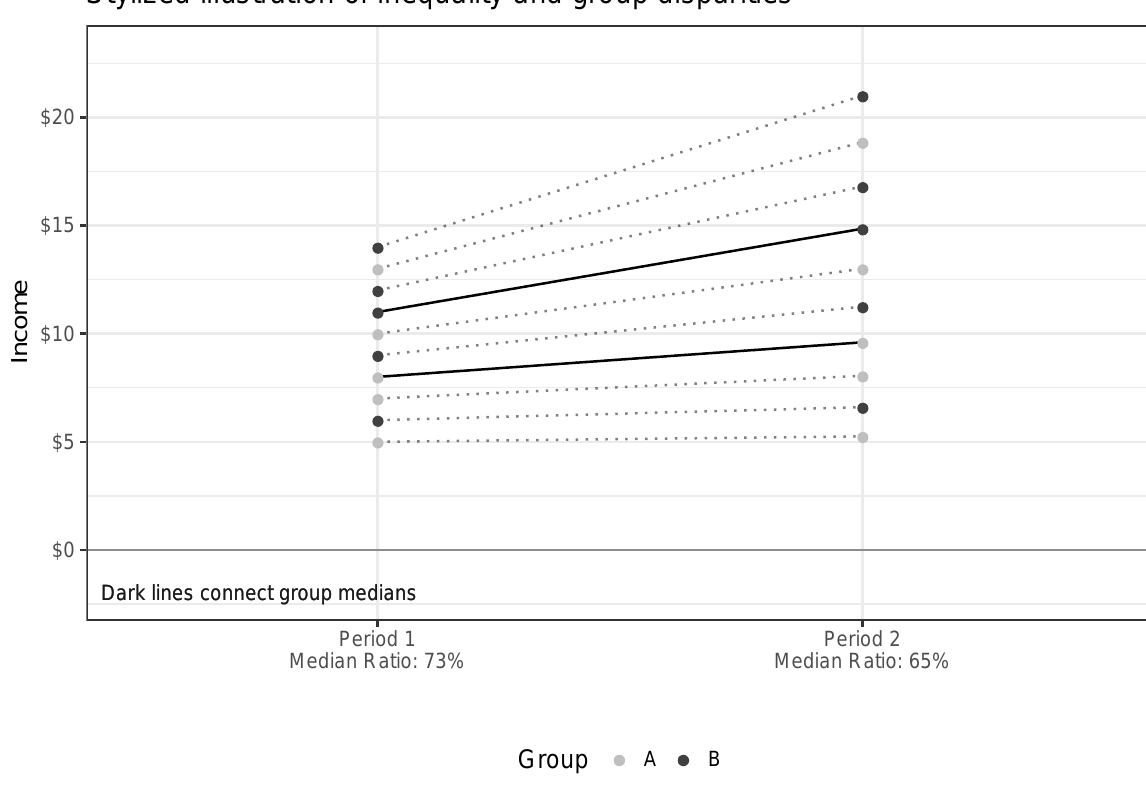
Figure 1: Rising income inequality can exacerbate cross-group disparities. As inequality rises from Period 1 to Period 2, the gap between the groups grows even though no further group-based stratification has